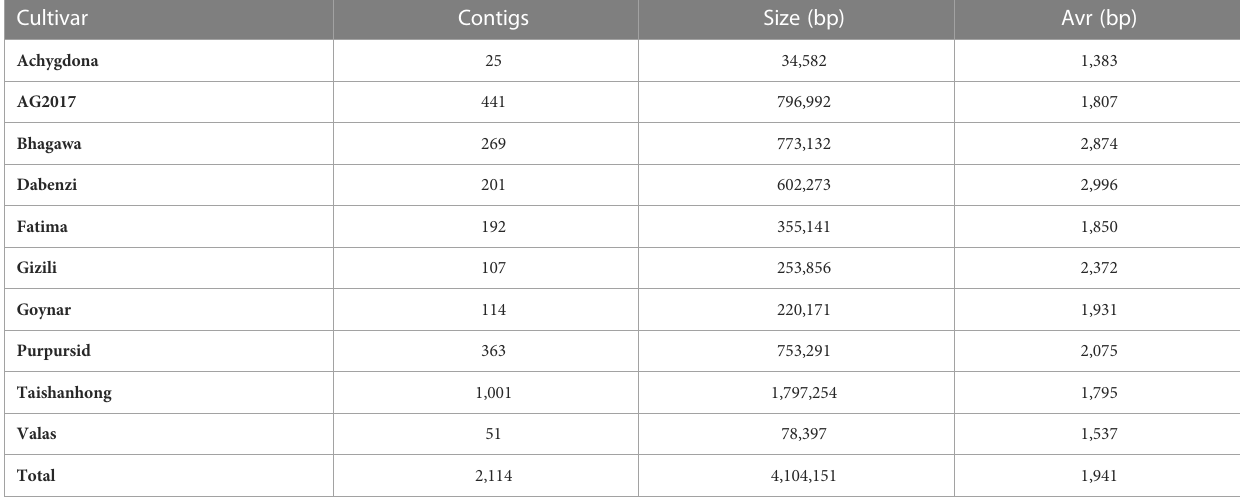
TABLE 1 Sequences existed in each cultivar that do not exist in the Tunisia reference genome. Cultivar